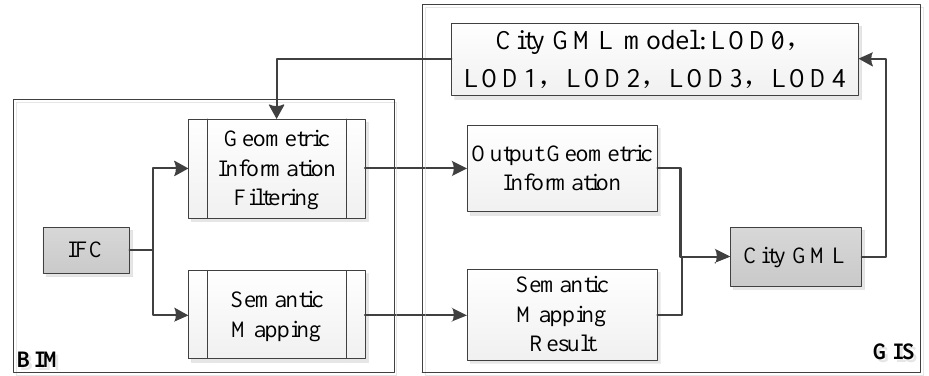
Figure 1. Data transformation between BIM and GIS